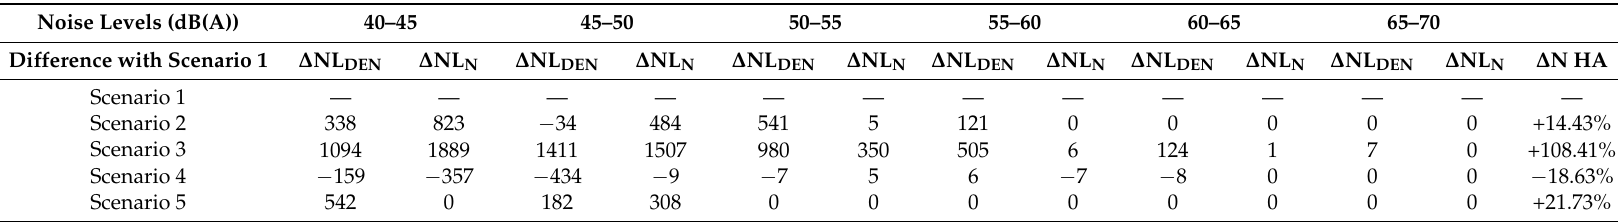
Table 3. Number of people exposed to noise in L DEN ( ∆ NL DEN ) and L N ( ∆ NL N ) dB(A) ranges in different scenarios reported as differences with respect to values for Scenario 1. ∆ N HA is the total number of highly annoyed citizens as a percentage with respect to Scenario